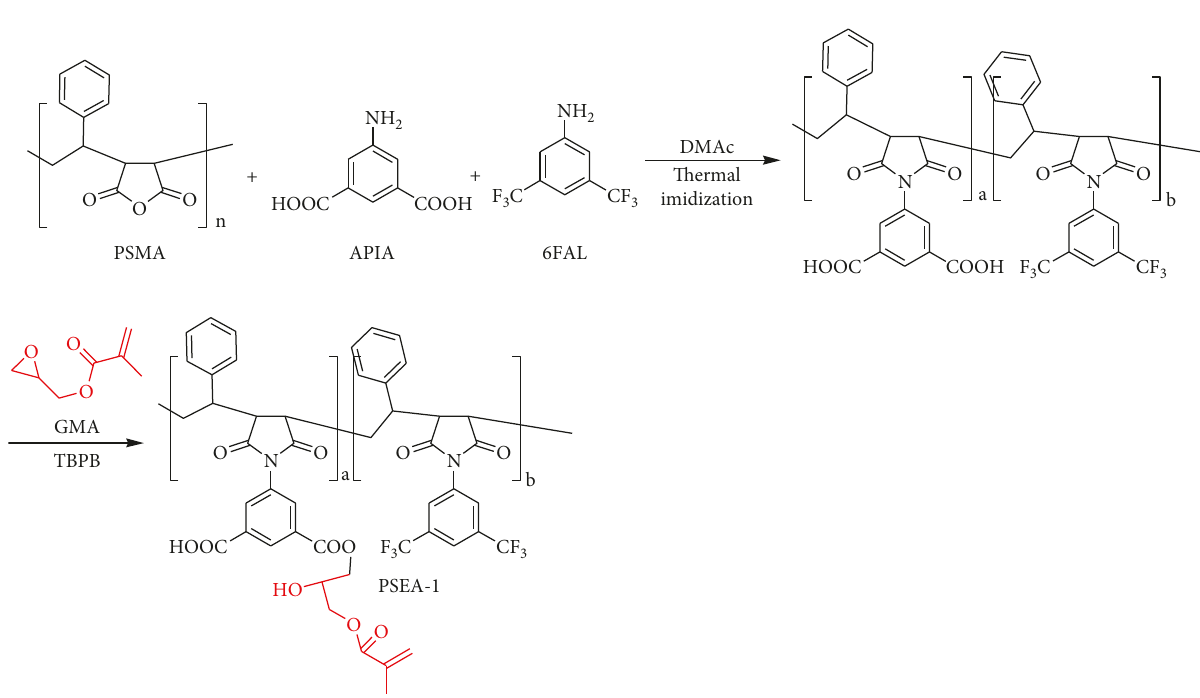
Figure 3: Synthetic scheme of acrylate-type side-chain polyimides.